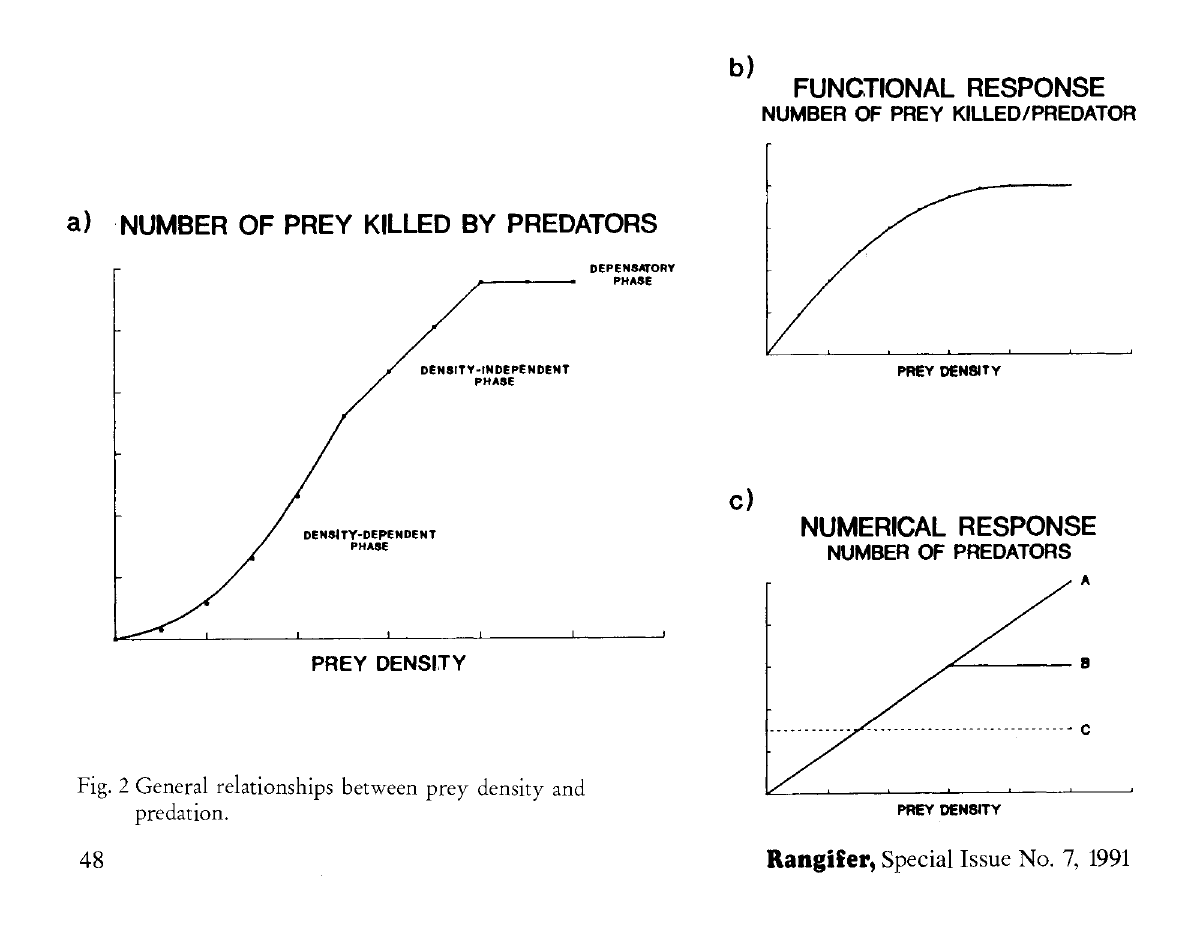
Fig. 2 General relationships between prey density and